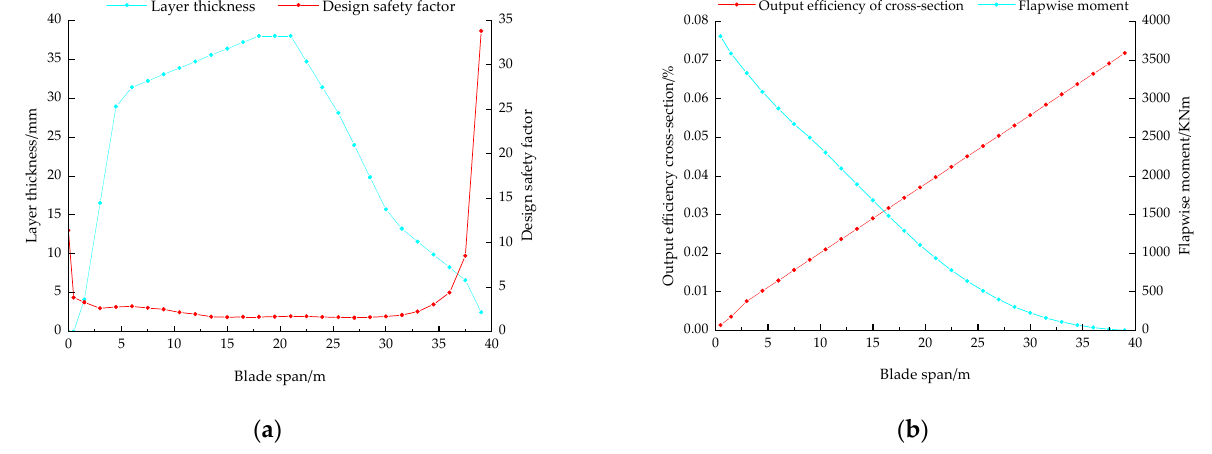
Figure 1. Structure distribution of the 40.3 m blade: ( a ) spar cap layup thickness and design safety factor; ( b ) ultimate flapwise moment and output efficiency of the cross-section.